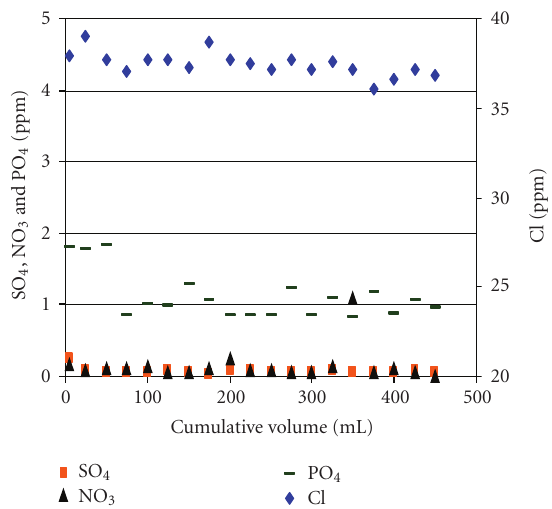
Figure 10: Breakthrough results for the novel ion exchanger using 50 ppm Cl, SO 4 , NO 3 , and PO 4 .